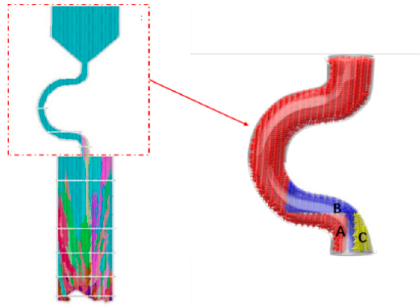
Figure 9. Simulation results of Grain A, B, C in the selector parts of C 1 : d w = 2.4 mm, d s = 8 mm.